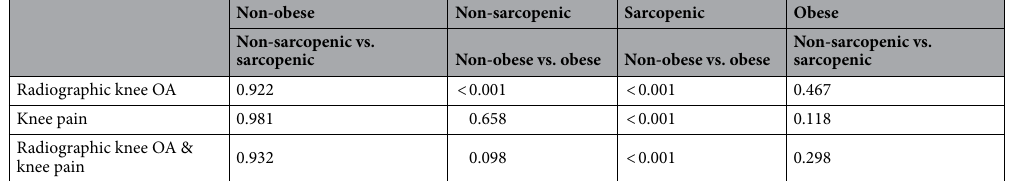
Table 3. Multiple comparison results of the prevalence of radiographic knee OA, knee pain and both radiographic and knee pain between each two groups of non-obese, non-sarcopenic, sarcopenic and obese 0.0083 is statistically significant. OA